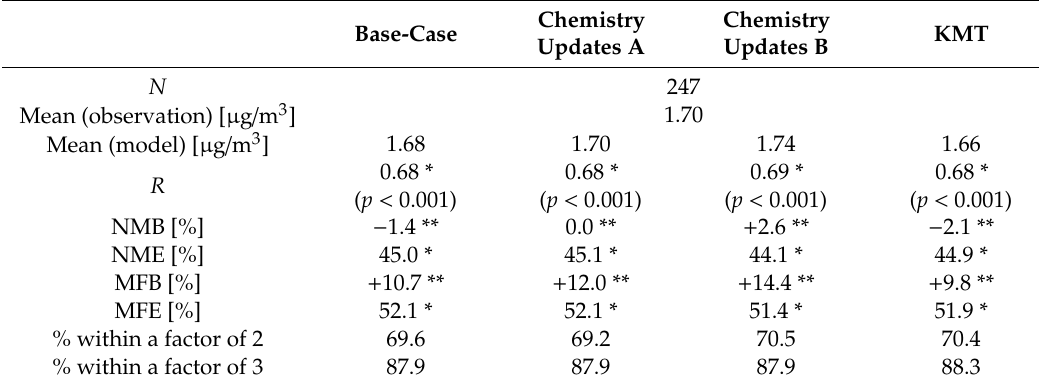
Table 3. Statistical analysis of model performance for SO 42– concentrations at the Tokyo site in domain 4 of